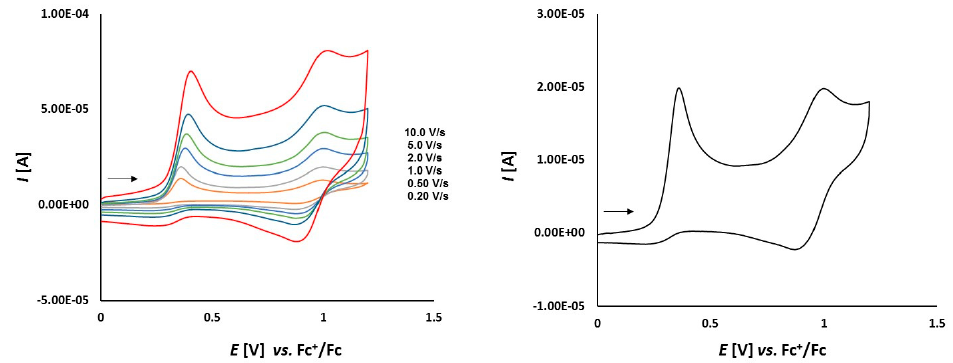
Figure 7. Cyclic voltammetry of complex 3d (1.0 mmol/L) in CH 2 Cl 2 -[ n Bu 4 N][BF 4 ] (0.1 m/L) solutions at various scan rates ( left ) and at v = 0.50 V/s ( right ). The potentials E are given in V and referenced to the Fc + /Fc couple. The arrows indicate the scan direction.